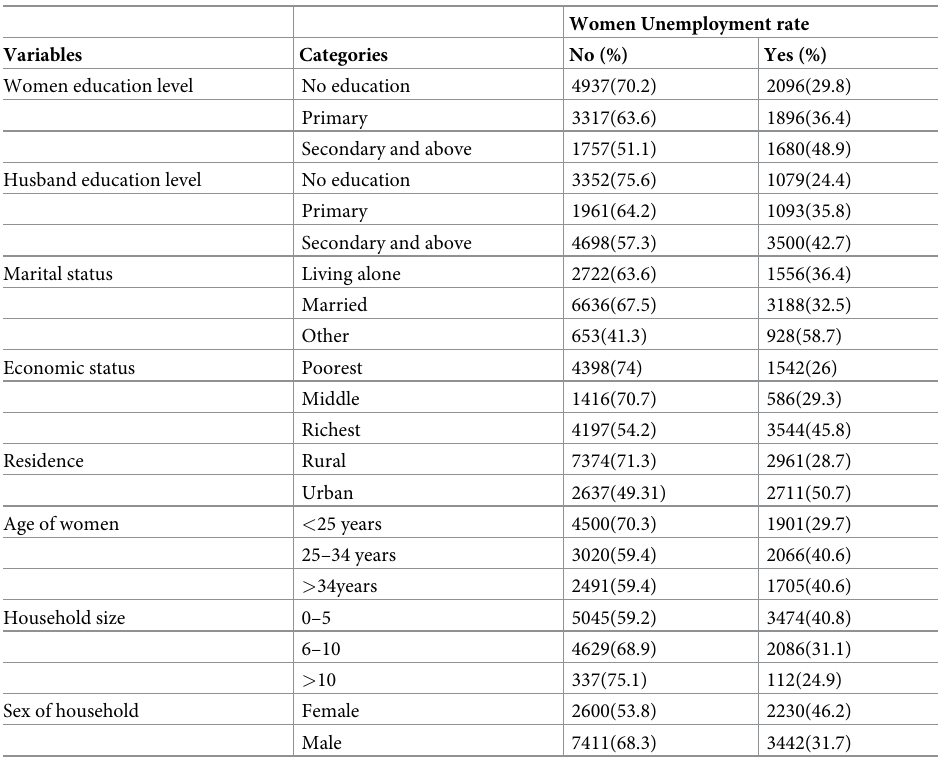
Table 1. Socio-demographic characteristics of study